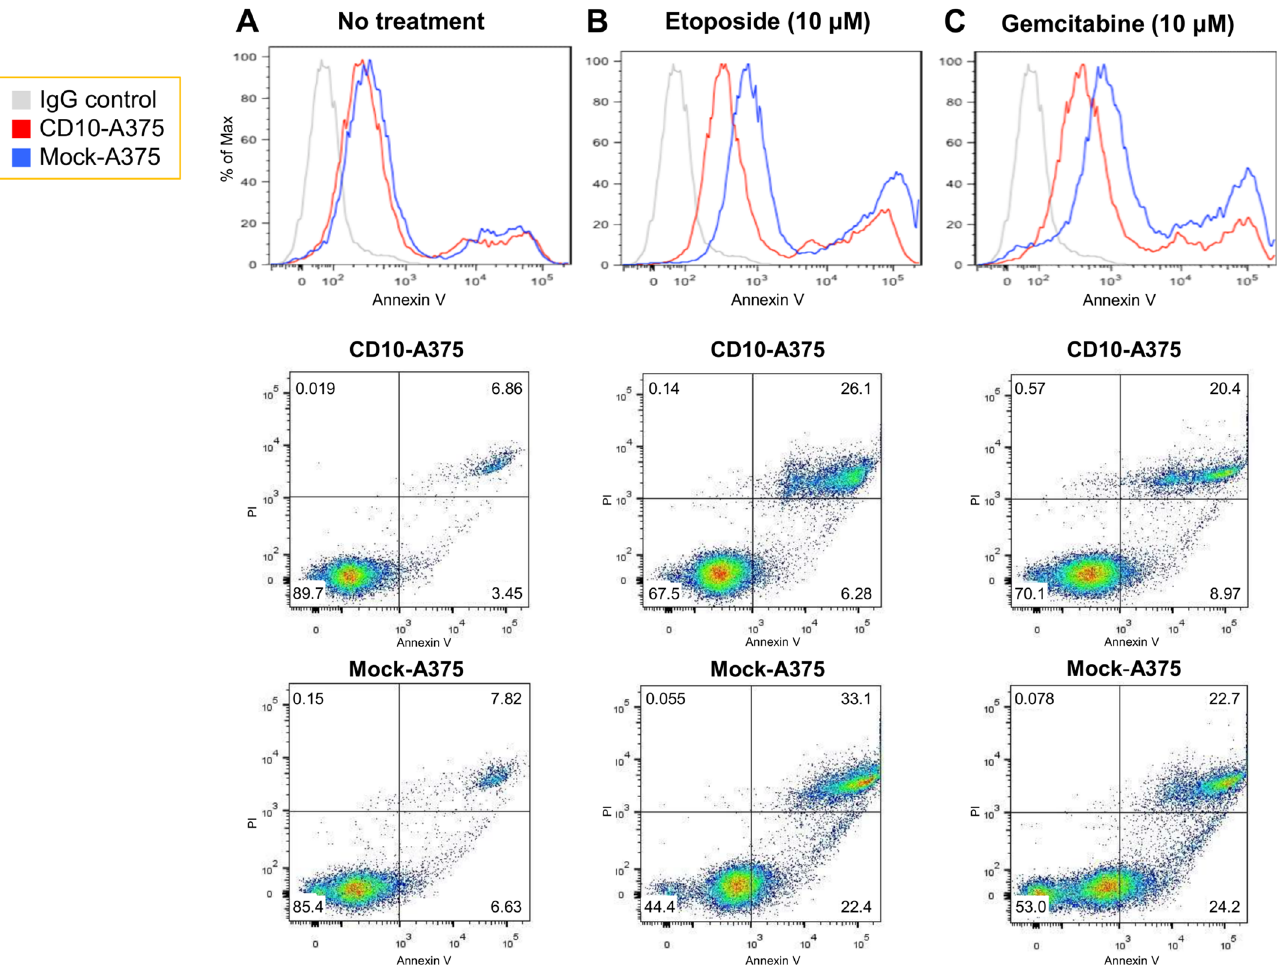
Fig 4. CD10 exhibits higher resistance to anticancer drugs. (A-C) Histogram (upper) and dot plot (lower) showing the proportion of Annexin V- and Annexin V/PI-positive cells 24 hours after treatment with anticancer drugs. CD10-A375 or mock-A375 cells were treated with etoposide (B) or gemcitabine (C) overnight. Cell were harvested and stained with Annexin V and PI, and 10,000 events were counted by flow cytometry. Without any treatment (A), the number of Annexin V-positive apoptotic or Annexin V/PI-positive dead cells was low and there was no difference between CD10-A375 and mock-A375. Under the treatment with the anticancer drugs, however, the number of apoptotic cells increased remarkably. CD10-A375 cells (red line) displayed a lower proportion of Annexin V-positive or Annexin V/PI-positive dead cells induced by anticancer drugs than mock-A375 (blue line), showing stronger resistance. Isotype control is shown with a gray